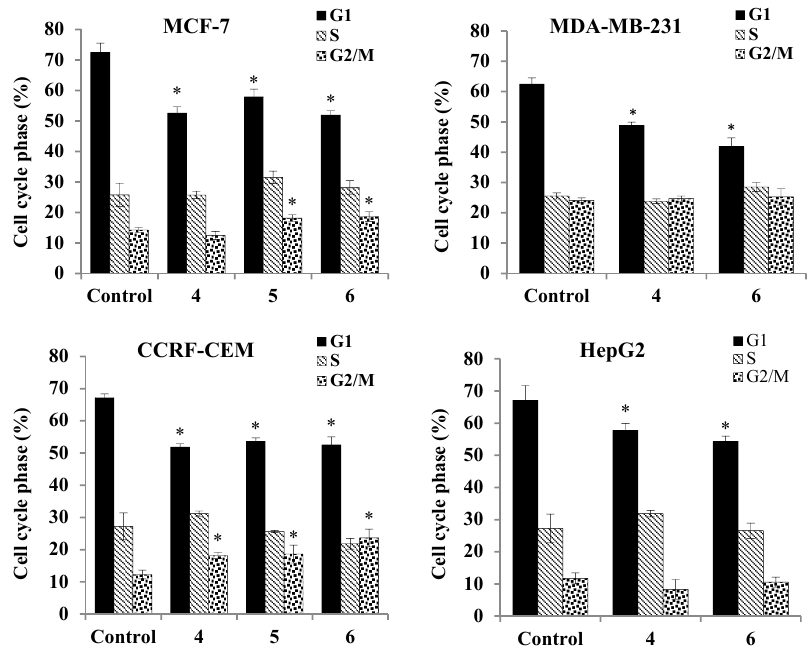
Figure 8. Cell cycle distribution of human cancer cells treated with compounds 4 , 5 and 6 . The cells were incubated with a IC 50 concentration of the compounds for 24 h and then analyzed cytometrically. The results represent mean ± SEM of the data from three to four individual experiments, each done at least in sextuplicate. * p < 0.05 vs. control. Table 3. Percentage of hypodiploid cancer cells calculated from the sub-G1 peak from DNA histograms estimated by cytometric analysis of the cell cycle. The values are the mean ± SEM of three independent experiments in 3–5 repeats each (* p < 0.05).